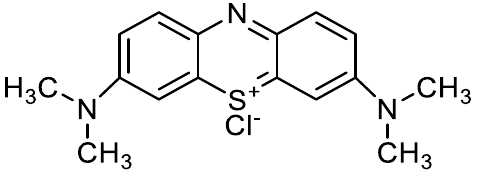
Figure 1. Chemical structure of methylene blue C 16 H 18 ClN 3 S × H 2 O.